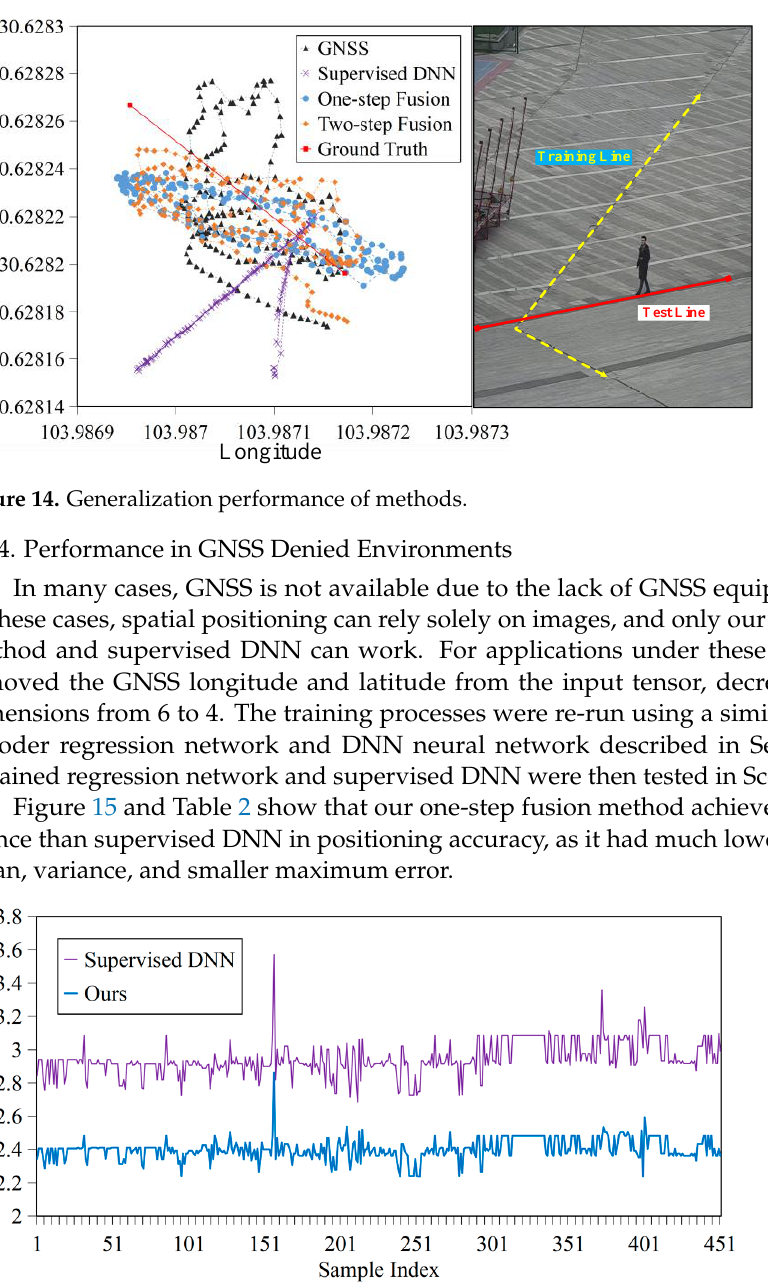
Figure 14. Generalization performance of methods.